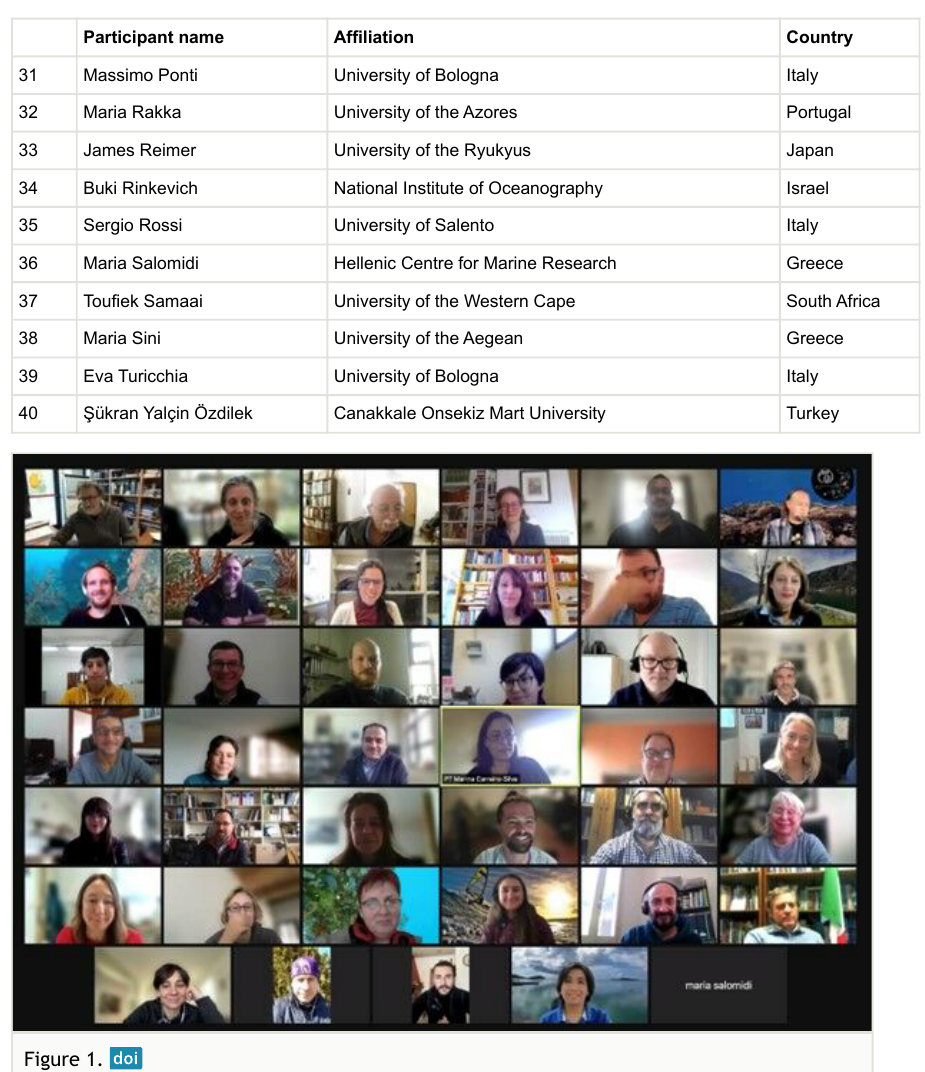
Screenshot from one of the Workshop plenary sessions (source: screenshot of the workshop